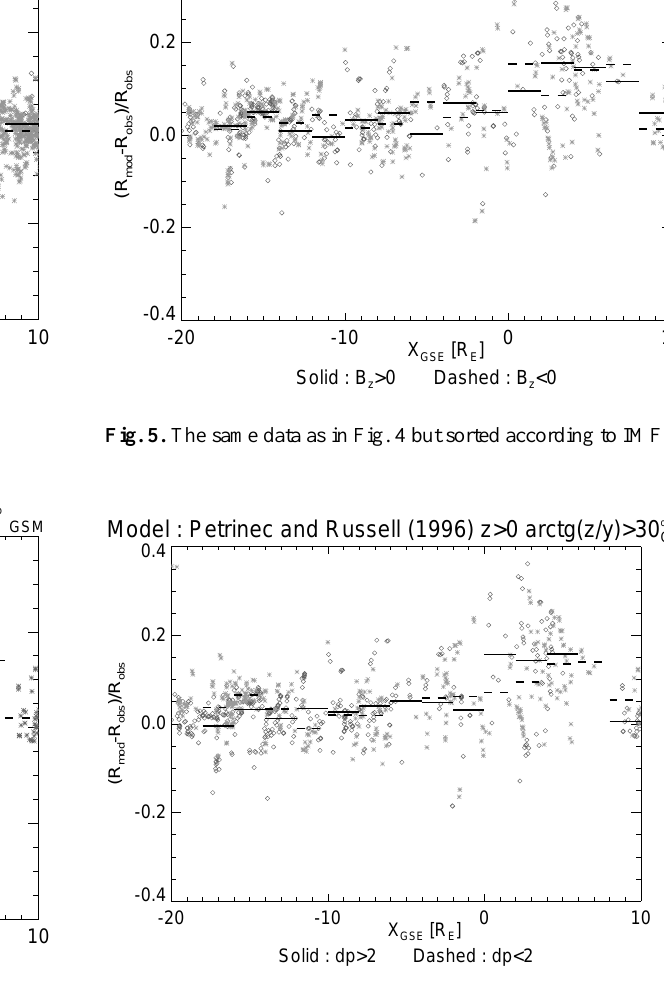
Fig. 6. The same data as in Fig. 4 but sorted according to solar wind dynamic